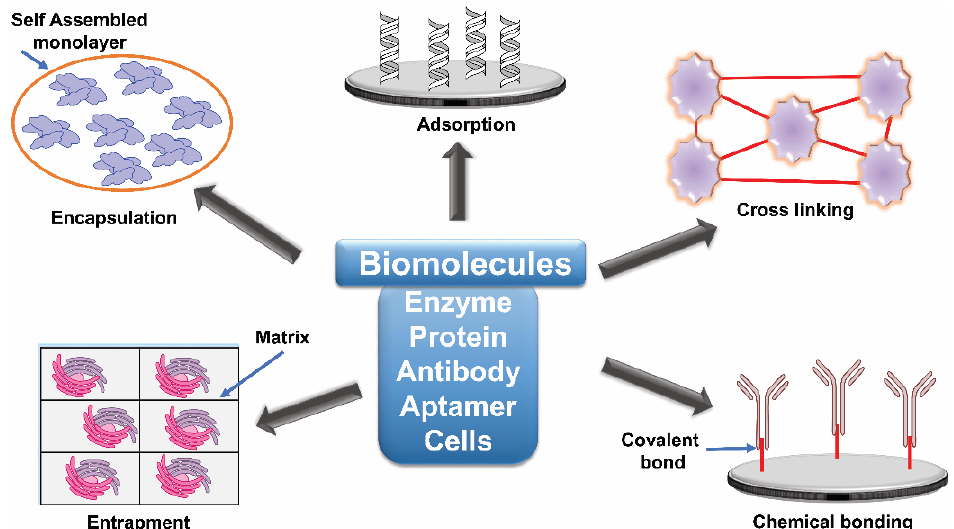
Figure 4. Immobilization methods for various biomolecules used in the construction of biosensors. Adsorption is a simple phenomenon where the biomolecules are attached through physical interactions generated between the carrier and enzyme through van der Waals forces, ionic interactions or hydrogen bonding. Glutaraldehyde is commonly used to cross-link enzyme molecules via the reaction of the free amino groups of lysine residues on neighbouring proteins. This is a desirable approach to achieve stronger immobilization than physical adsorption processes. Entrapment is the physical attachment of enzymes in a limited space. Matrix and membrane entrapment, including microencapsulation, are the two major methods used. Membranes include cellulose acetate, polycarbonate, collagen, and Teflon or other polymers. Encapsulation is used to avoid any negative influence on the structure of the enzyme, which uses a sol–gel, which is a chemically inert glass that can be shaped in any desired way. More recently, liposomes have been employed with bilayer-forming amphiphilic molecules, such as